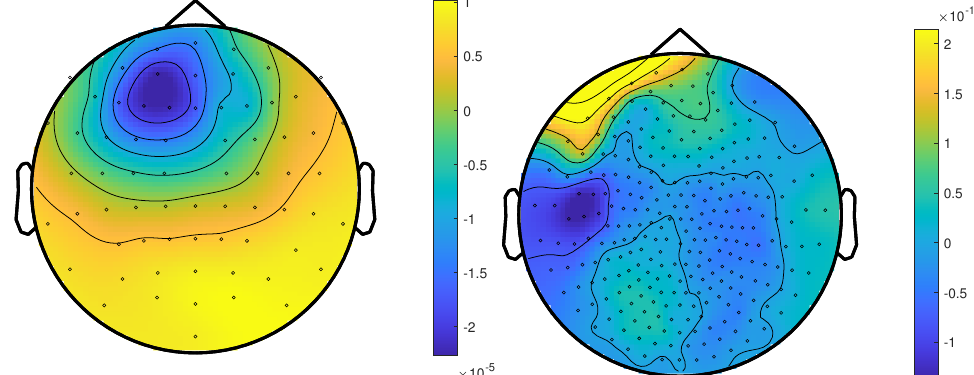
Figure 7. Butterfly plot of the averaged spikes of patient 1 in the EEG (red), MEG (blue), and MEEG (blue and red). The time point of the rising flank at − 4 ms is marked with a vertical line from above and below. The horizontal line marks the zero activity line.